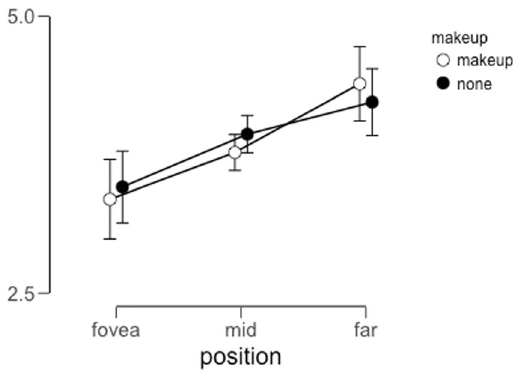
Figure 6. Average perceived distortion within each condition for Experiment 3A. Error bars represent 95% credible intervals for each data point.